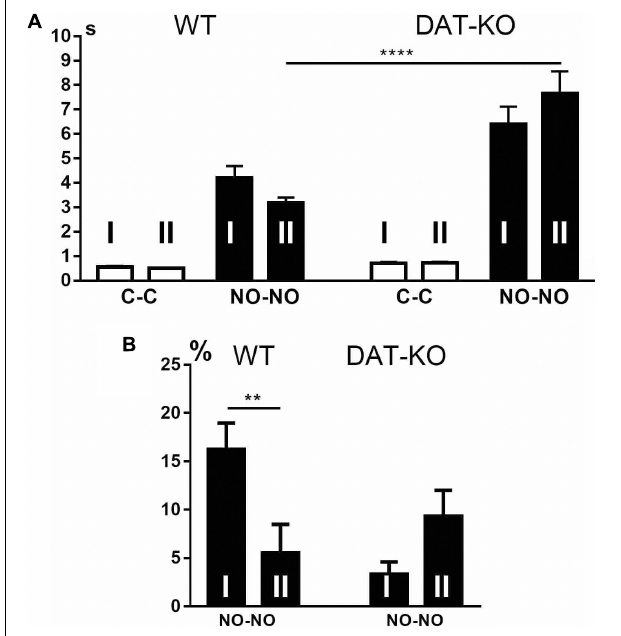
FIGURE 8 | Comparison of the time of object exploration by WT and DAT-KO rats (A) , and the number of erroneous trials in WT and DAT-KO rats during novel object presentations (B) in the first (I) and second (II) blocks of experiments. White columns, cube presentation (C-C); black columns, novel object presentations (NO-NO); ** p < 0.01; **** p < 0.0001; one-way Kruskal–Wallis test with Dunn’s multiple-comparison post hoc test. WT, wild-type; DAT-KO, dopamine transporter